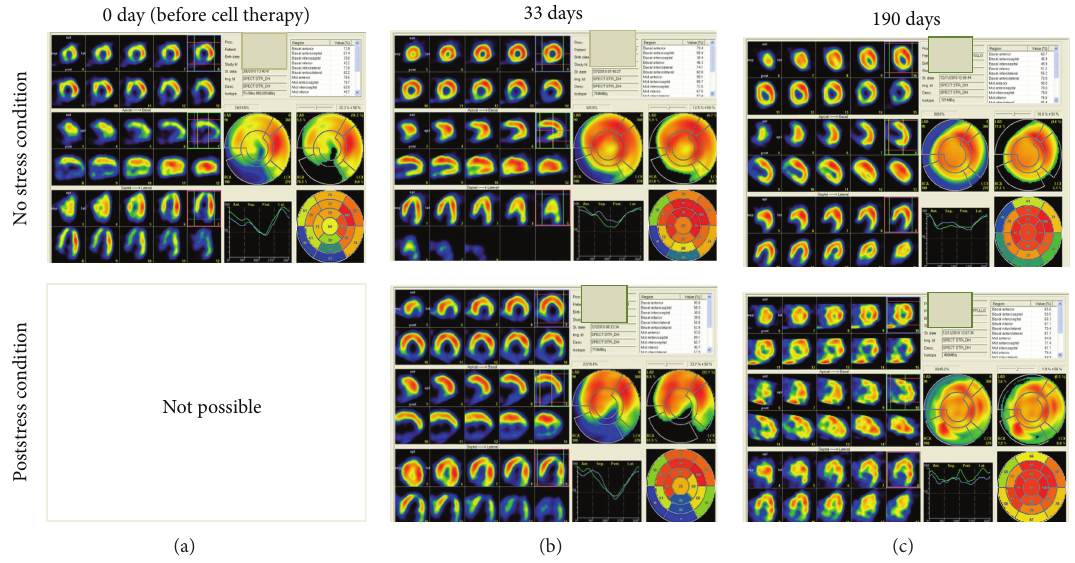
Figure 2: Kinetic of the areas that benefit from myocardial revitalization after cell therapy carried out by myocardial scintigraphy before and after 33 and 190 days. The strong uptake of Tc99 isotope in the inferoseptal region of the heart in poststress condition showed by arrow. (black, no perfusion; blue-green-yellow-red, increasing perfusion).